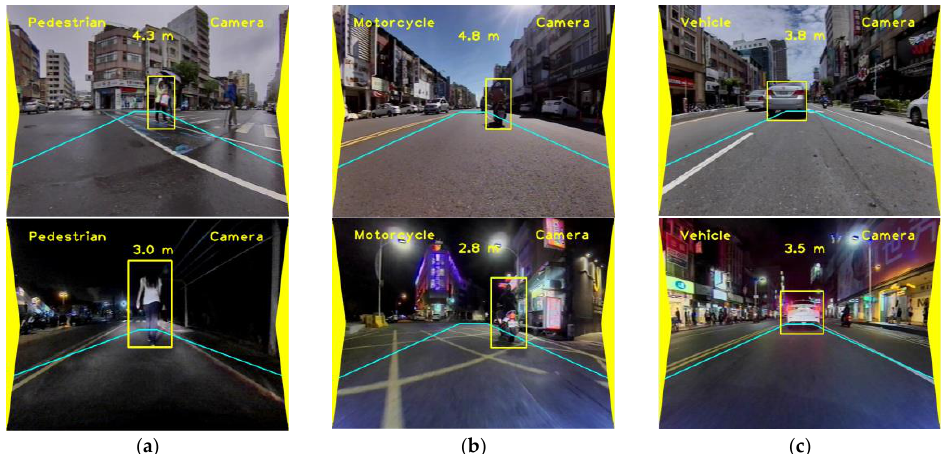
Figure 18. Detection results of a vision-based subsystem, upper row: daytime, lower row: nighttime